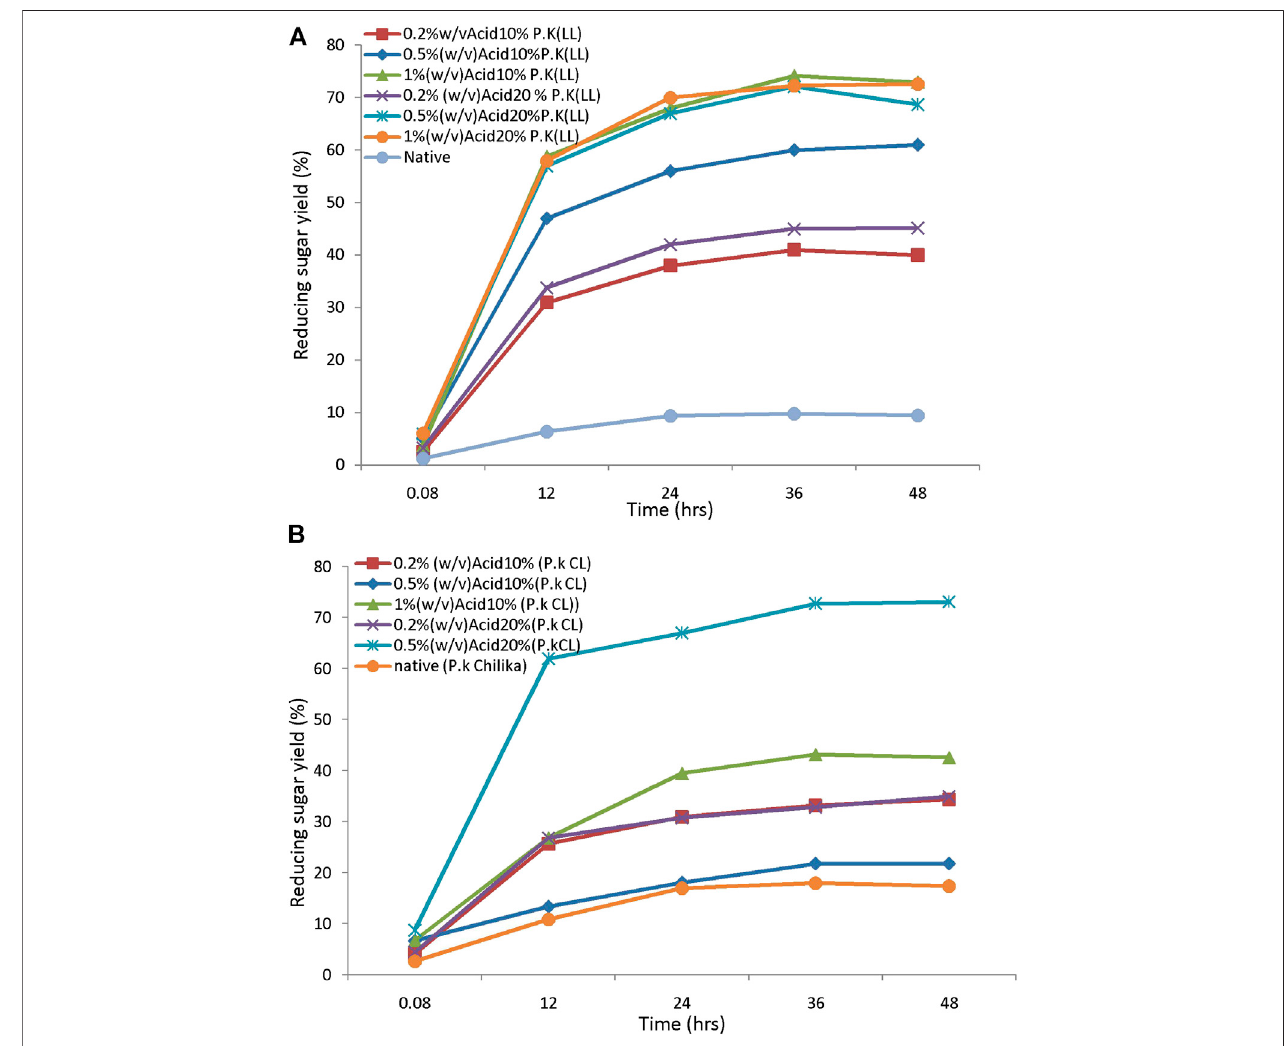
FIGURE 5 | The enzymatic hydrolysis ef fi ciency of acid-pretreated tall reed biomass: (A) Loktak Lake and (B) Chilika Lake.